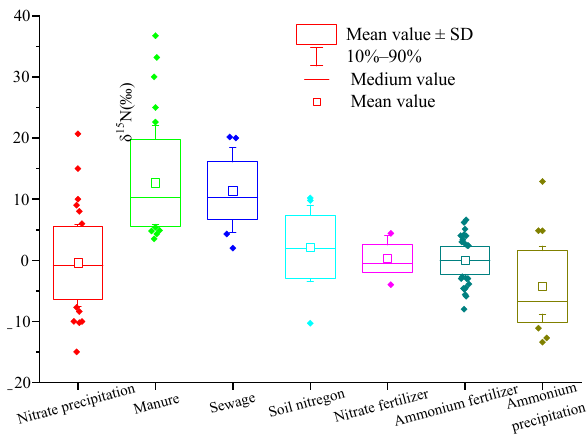
Figure 1. The box plots of δ 15 N values of NO 3 − from different sources. Note: (1) data source: literature [39–71]; number of samples: atmospheric deposition NO 3 − : n = 61; manure: n = 58; sewage: n = 24; soil nitrogen: n = 23; NO 3 − chemical fertilizer: n = 18; NH 4+ chemical fertilizer: n = 117; atmospheric deposition NH 4+ : n = 31.